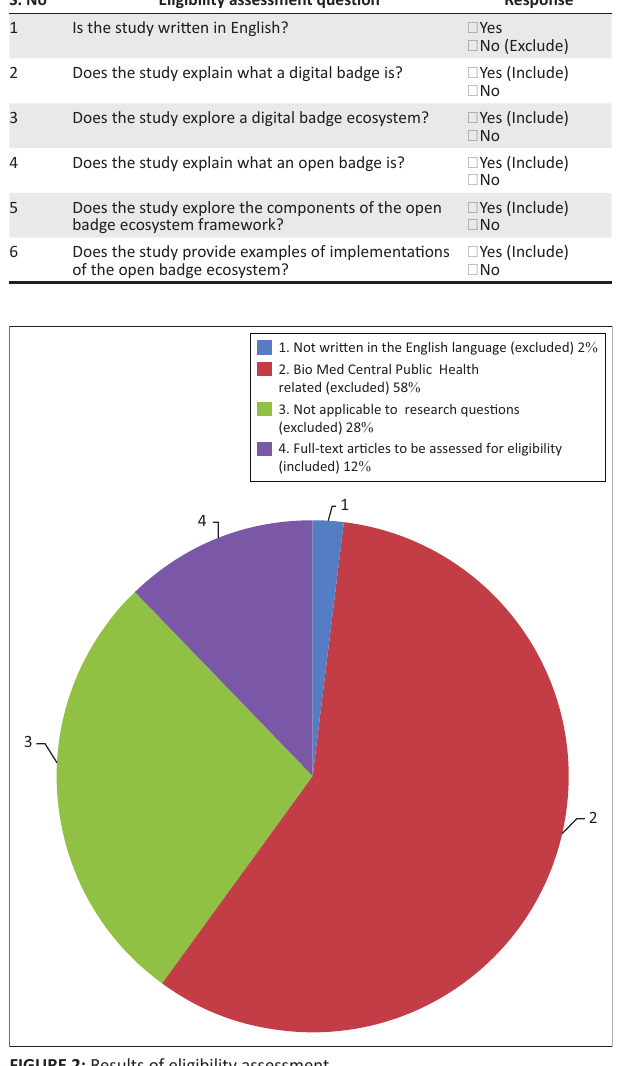
FIGURE 2: Results of eligibility assessment.